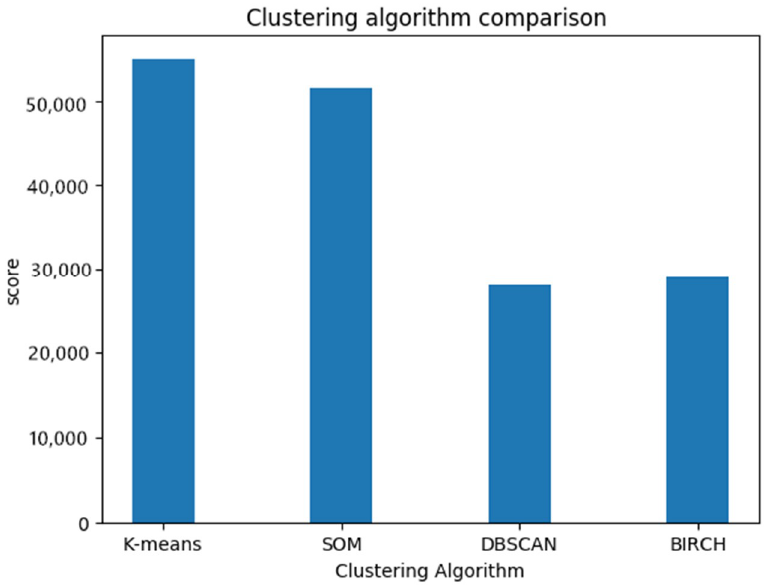
Figure 6. Comparison of the clustering quality of four algorithms.